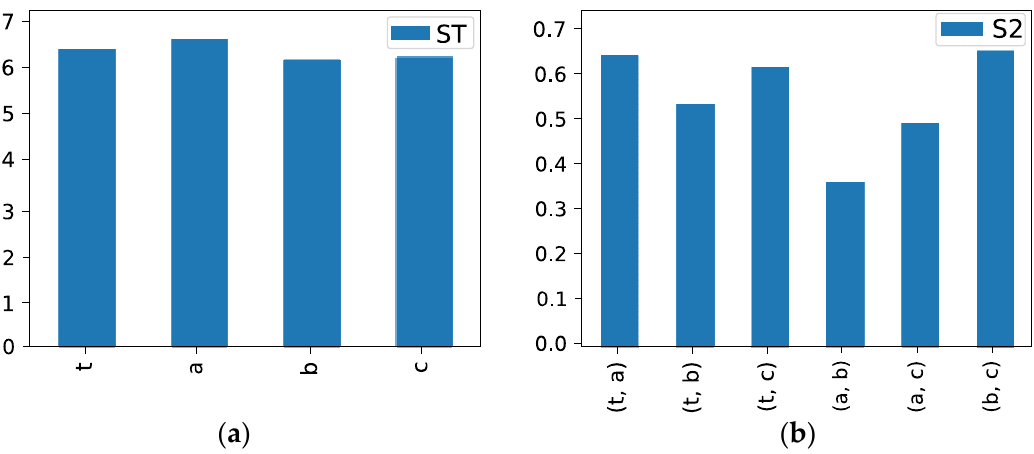
Figure 12. Sensitivity analysis of SEA: ( a ) ST at 95% confidence level; ( b ) S2 at 95% confidence level.